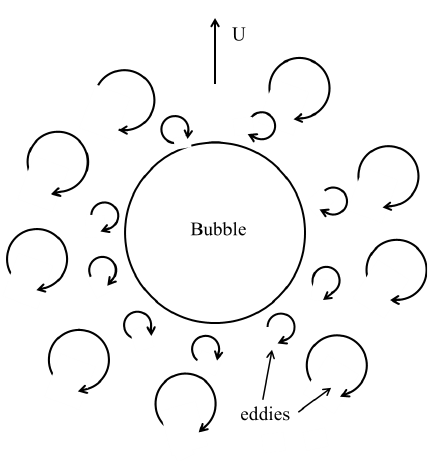
Figure 3. Schematic representation of the surface renewal